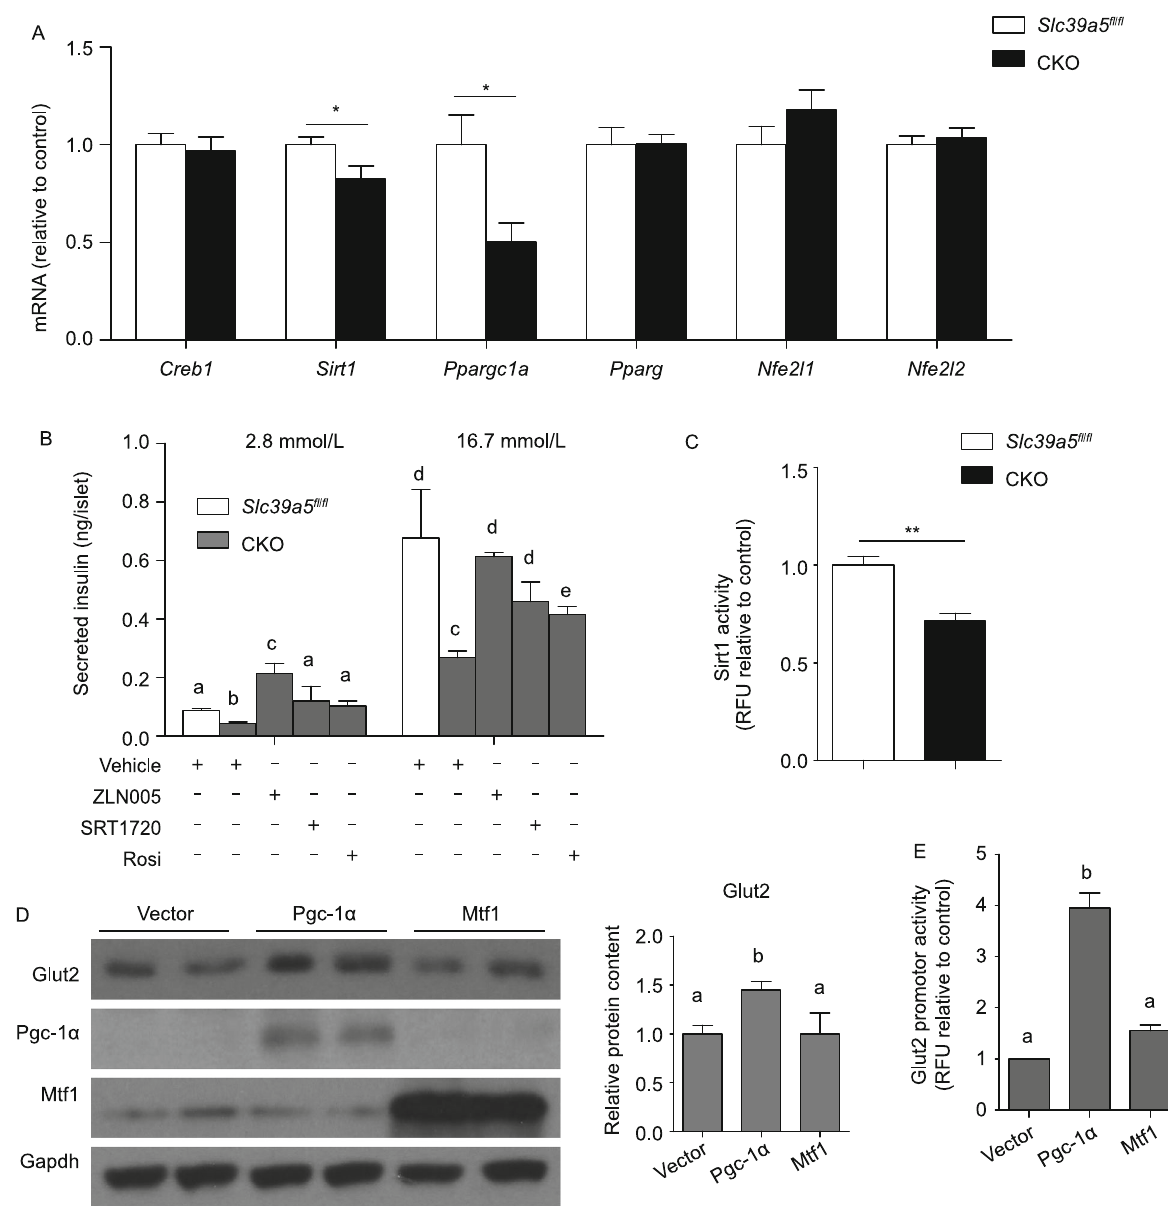
Figure 4. Slc39a5-regulated insulin secretion in β -cells is mediated by Pgc-1 α . (A) Creb1 , Sirt1 , Ppargc1a , Pparg , Nfe2l1 and Nfe2l2 mRNA levels were measured in pancreatic islets from Slc39a5 fl / fl and CKO mice ( n = 4 mice per group). (B) Secreted insulin levels were measured in pancreatic islets isolated from Slc39a5 fl / fl and CKO mice after treated with ZLN005, SRT1720, or rosiglitazone (Rosi) and stimulated with 2.8 or 16.7 mmol/L glucose. (C) Sirt1 enzyme activity was measured in islets from Slc39a5 fl / fl and CKO mice ( n = 4 mice per group). (D) MIN6 cells were transfected with either Pgc-1 α or Mtf1, and Western blot analysis was performed for the indicated proteins. The relative Glut2 expresion was quanti fi ed by using integrated optical densitometry of blots. (E) Glut2 promoter activity was measured using a dual luciferase reporter assay in MIN6 cells transfected with either Pgc-1 α or Mtf1 ( n = 3 per group). The data in panels (B) and (E) were analyzed by ANOVA, and groups with different letters differed signi fi cantly; the data in panels a and c were analyzed using a Student ’ s t -test (* P < 0.05 and ** P <